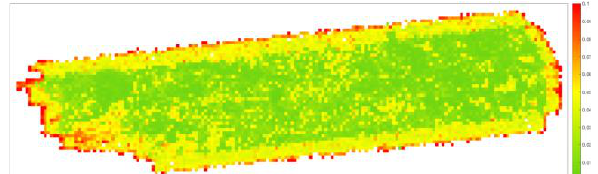
Figure 3. Color-coded visualization of the tie point standard de- viation CBA layer for Munich Central, hierarchical AT. Color scale is between 0 and 0.010 m or ~ 3 GSD, with “green” areas < 1 GSD.